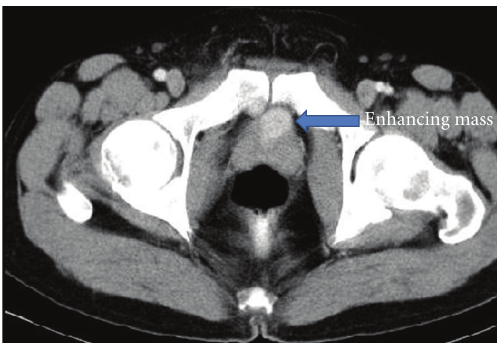
Figure 2: The tumor cells show the characteristic zellballen cells, with abundant eosinophilic cytoplasm and an ill-defined wall separated by fibrovascular stroma. Mitotic figures are not observed. Hematoxylin-Eosin Stain (X400).